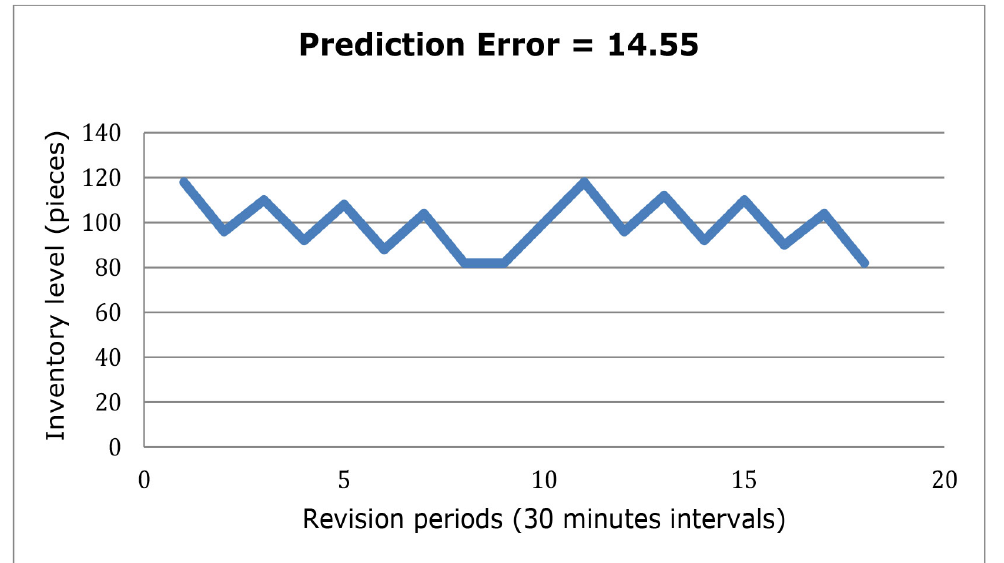
Figure 3. Inventory level based on our proposed